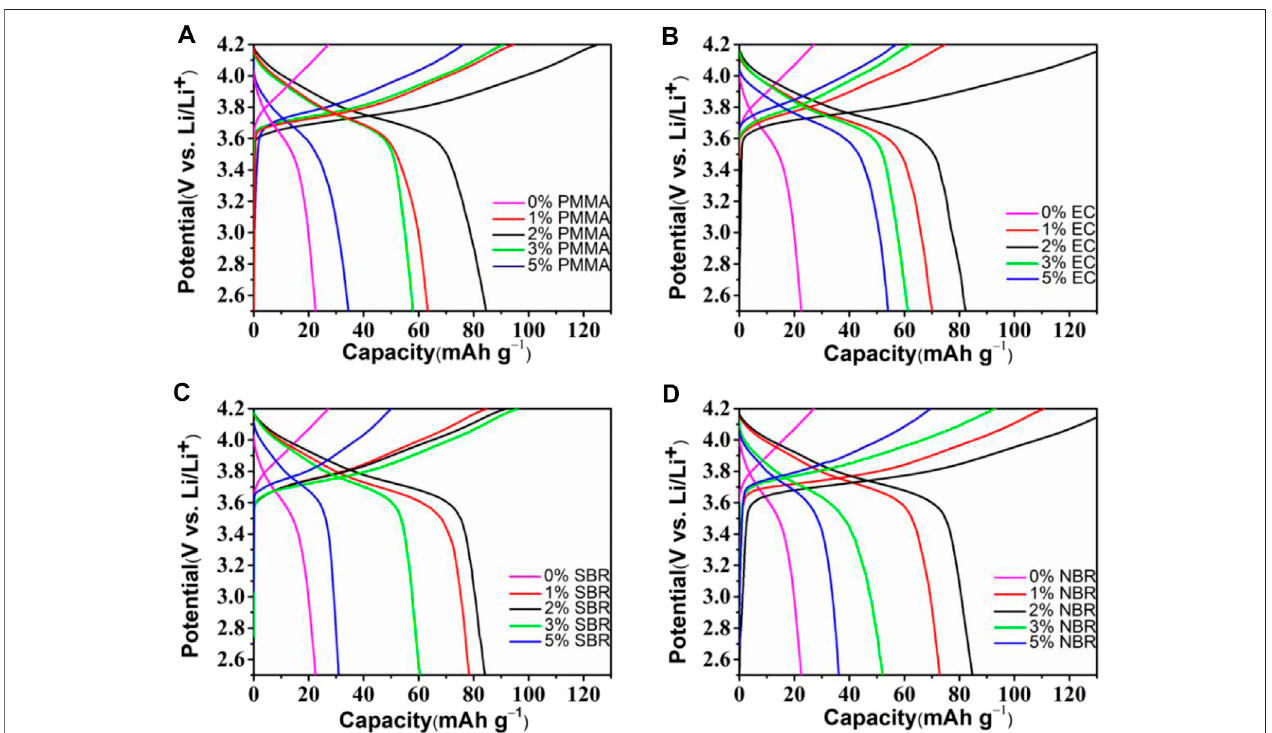
FIGURE 3 | Initial charge – discharge pro fi les of cathode composites with different amount of binder (A) PMMA, (B) EC, (C) SBR, and (D) NBR.